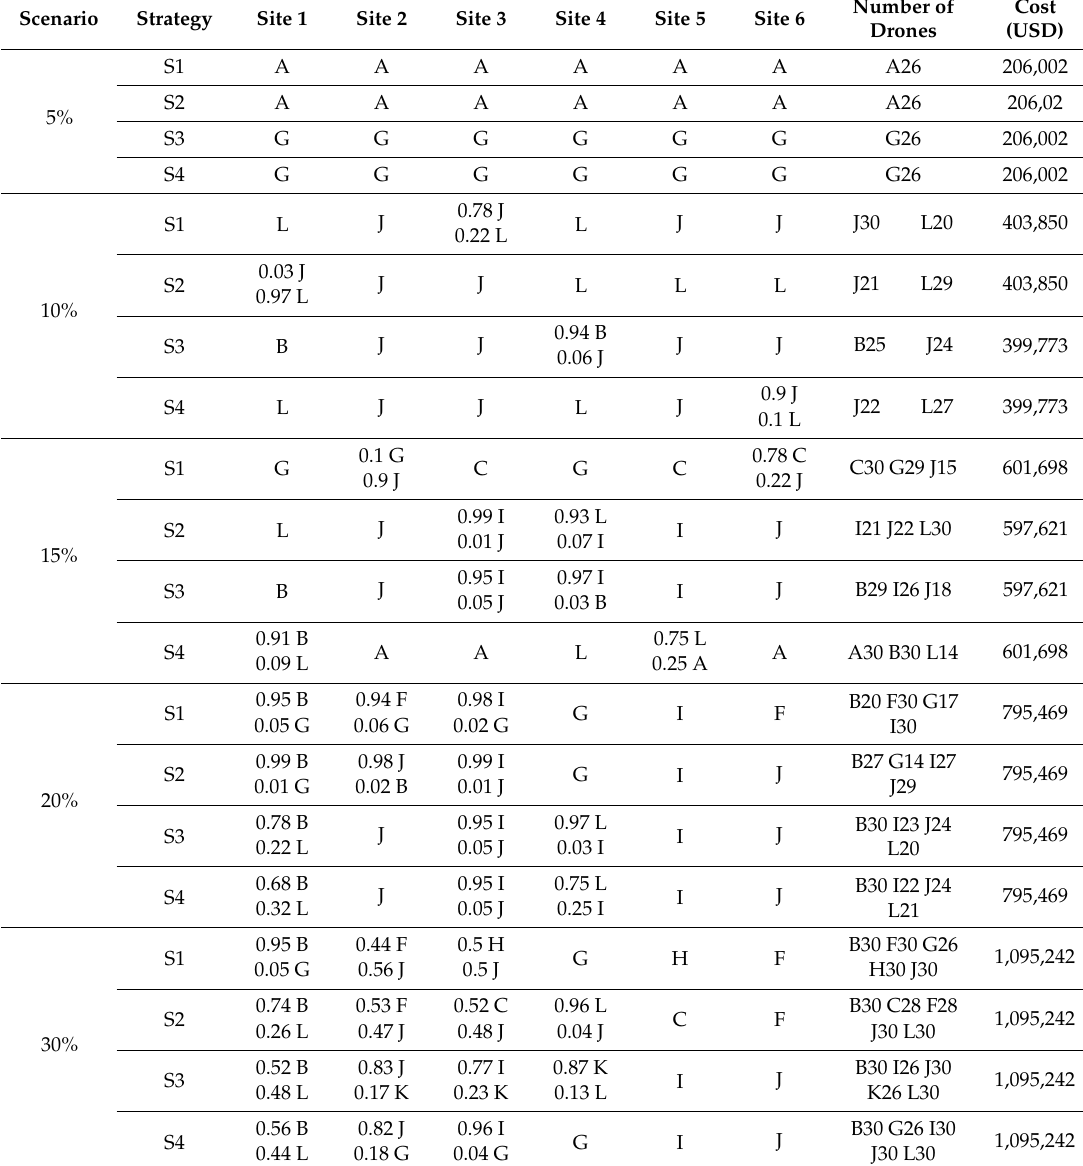
Table 2. Numerical